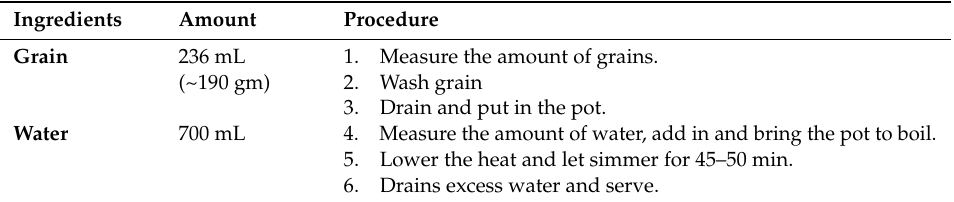
Table 2. Preparation of cooked grain samples.